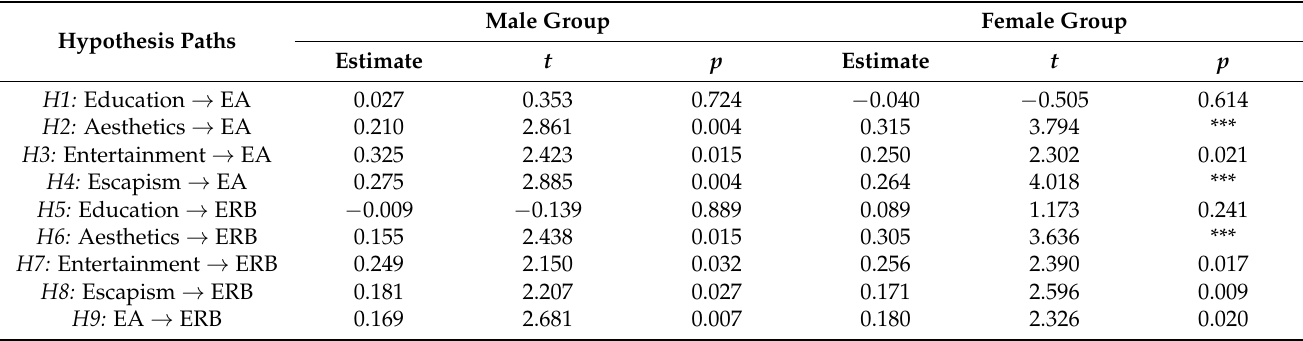
Table 6. Results of the moderating